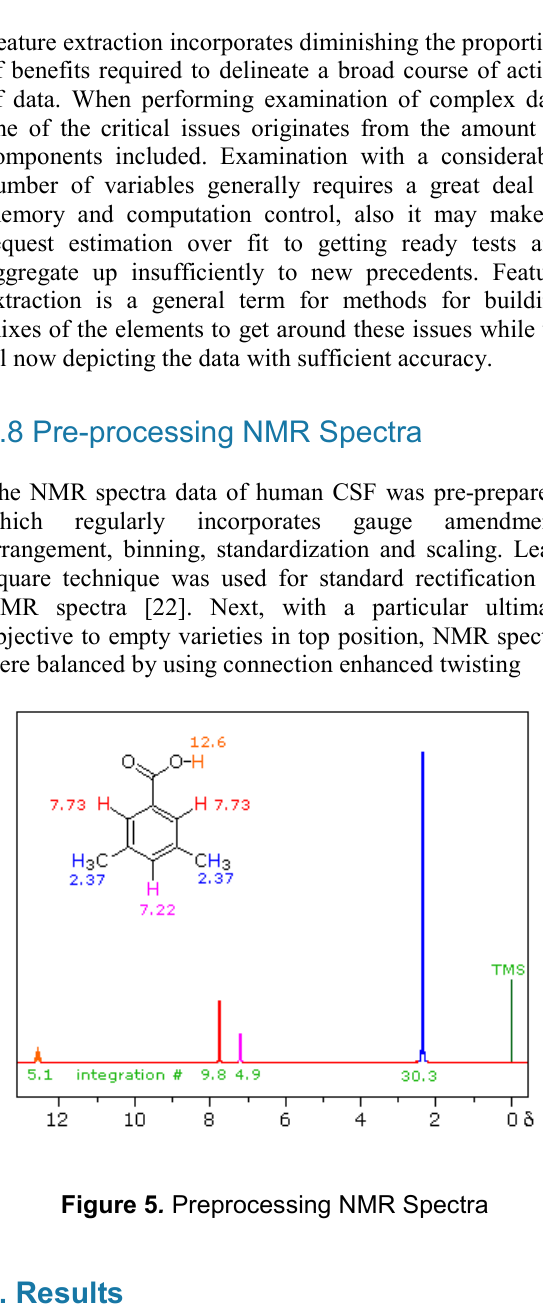
Figure 4 . Wrapper Method